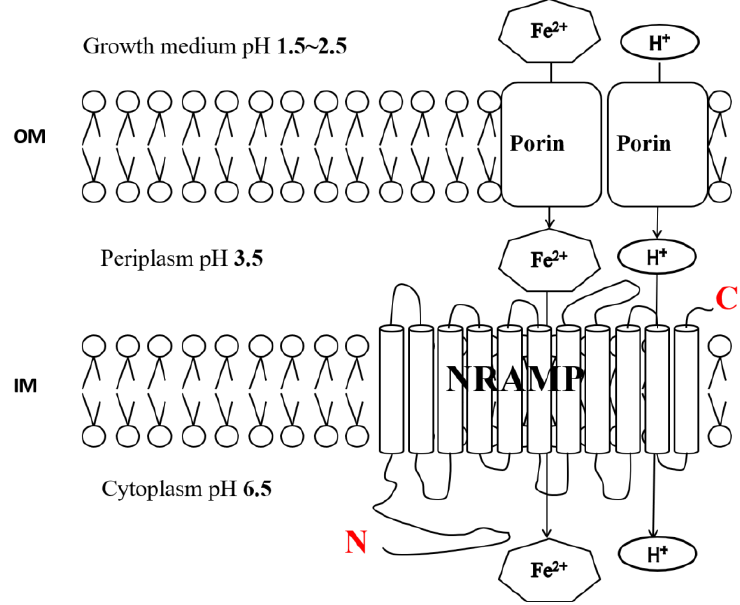
Figure 4. Proposed model for NRAMP-mediated Fe 2+ uptake. Fe 2+ and H + diffuse through the porins of the outer membrane (OM) and are subsequently transported into the cytoplasm by NRAMP anchored in the inner membrane (IM).